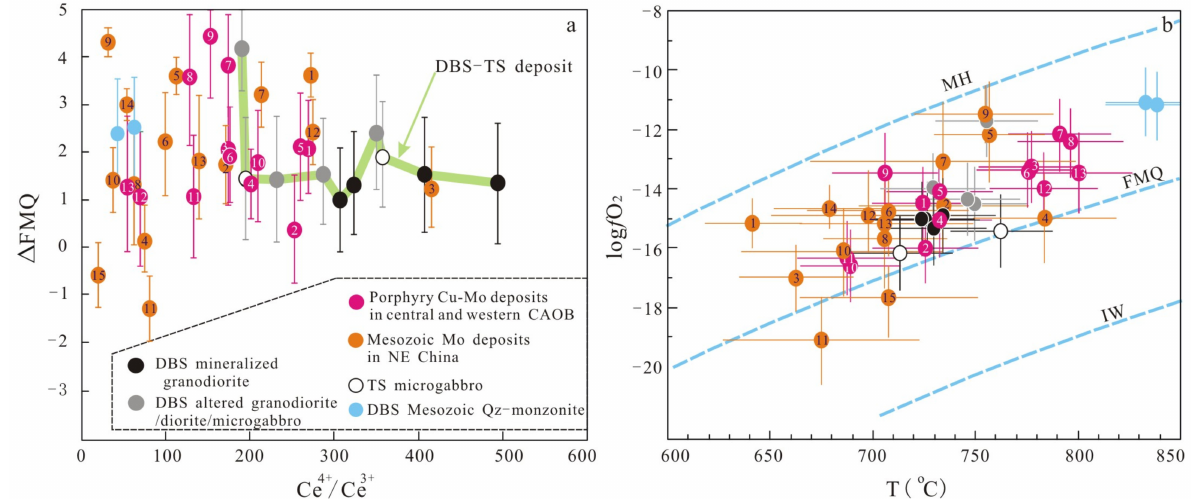
Figure 10. Plots of ( a ) ∆ FMQ versus Ce 4+ /Ce 3+ and ( b ) log f O 2 versus T( ◦ C) for individual samples from the DBS-TS porphyry Cu-Mo deposits. Black, grey, white and light blue circles in ( b ) are the same as in ( a ). Shown also for comparison includes 13 ore-bearing intrusions in central and western CAOB (pink solid circle with numbers: 1–2 = tonalite porphyry from Bozshakol, 3 = diorite from Nurkazghan, 4–5 = granodiorite porphyry and granodiorite from Kounrad, 6 = tonalite porphyry from Aktogai, 7–8 = granodiorite from Erdenet, 9 = granodiorite porphyry from Koksai, 10–11 = tonalite porphyry from Tuwu-Yandong, 12 = granodiorite from Borly, and 13 = diorite from Baogutu; source data from [16]; values of log f O 2 and T are recalculated in this study) and 15 Mesozoic Mo deposits in NE China (orange solid circle with numbers are the same as in Figure 1b; source data from [18]). MH and IW in Figure 10b are oxygen fugacity buffers for magnetite-hematite and iron-wustite,